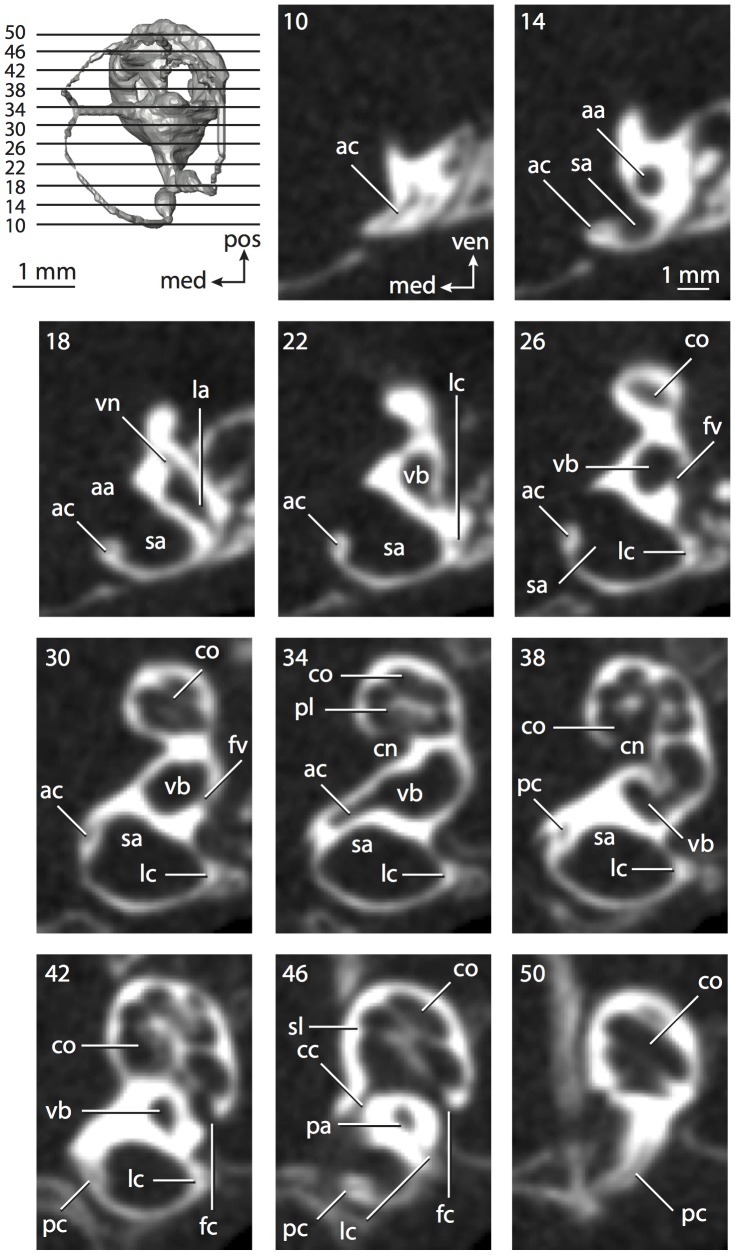
CT slices through ear region ofNycteris grandis.Abbreviations listed at the end of the Materials and Methods section.